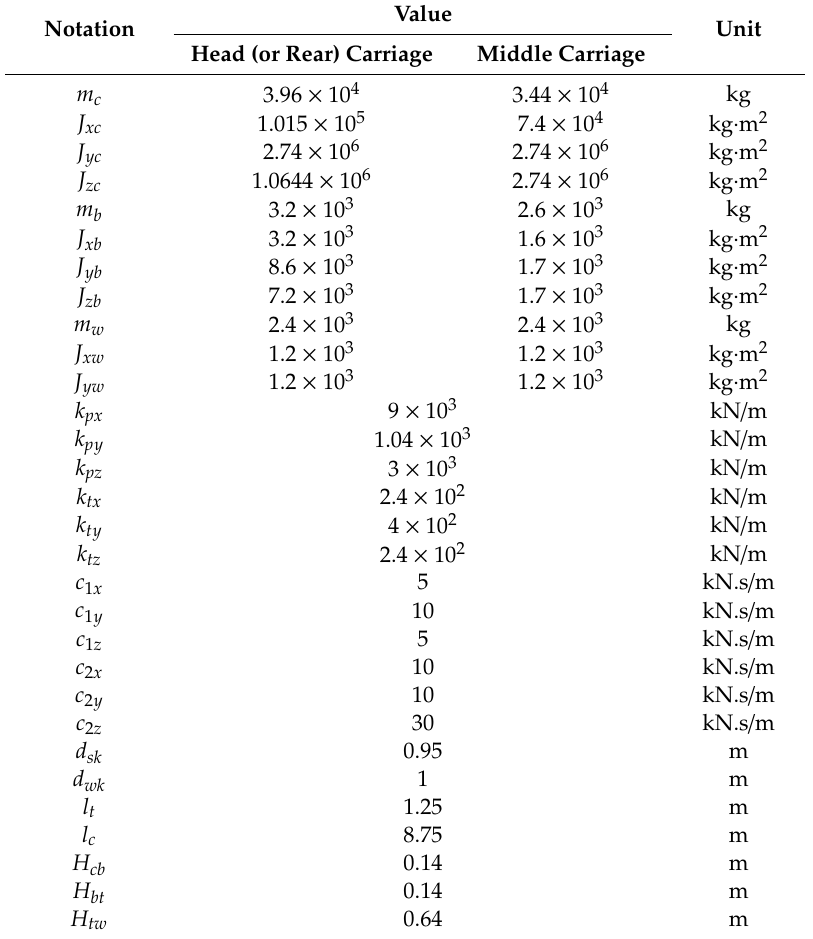
Table 1. Value of the main parameters of the vehicle